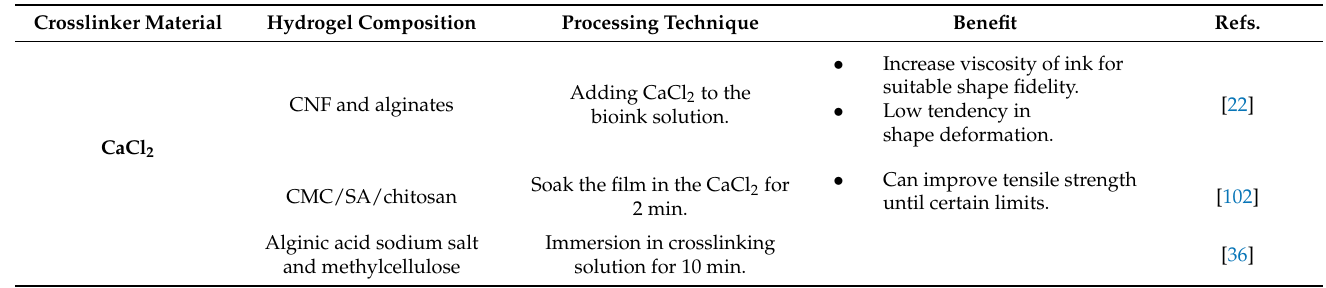
Table 2. Review on the effect and application of crosslinking toward hydrogel